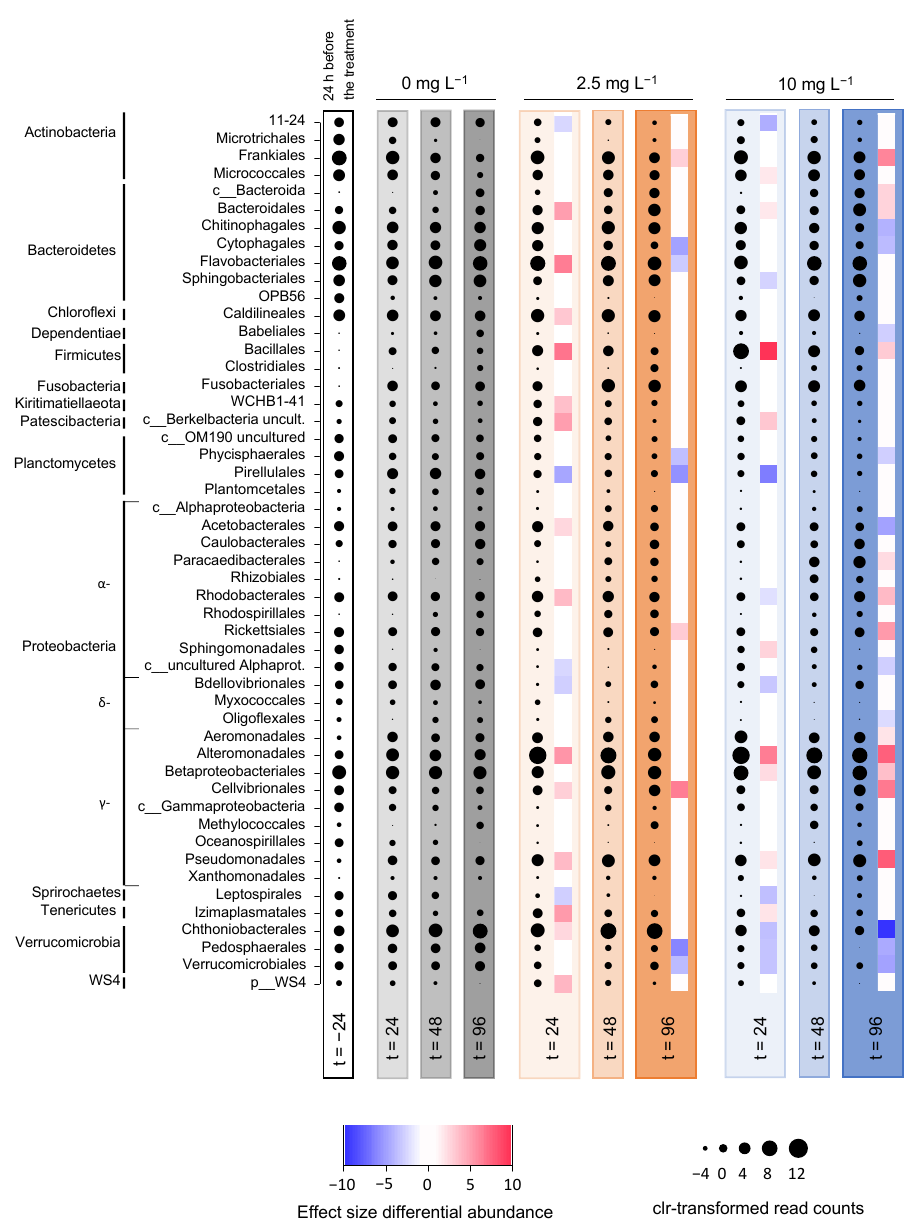
Figure 6. Microbial community composition during the incubation experiments in August. The graph shows the relative abundances as clr-transformed read counts of bacteria at the order level for each of the time points during the August treatment. The first column represents the average relative abundances in the lake prior to the incubation experiments (t = − 24 h, with n = seven biological replicates). The other columns represent the relative abundances in the incubation experiments at three subsequent time points (t = 24, 48 and 96 h, with n = four biological replicates per time point). Gray columns represent the control incubations (0 mg L − 1 H 2 O 2 ), orange columns—the 2.5 mg L − 1 H 2 O 2 -treated incubations, blue columns—the 10 mg L − 1 H 2 O 2 -treated incubations. Differential abundances of orders between the treated and control incubations at t = 24 h and t = 96 h were calculated using ALDEx2. Effect sizes of the statistical test (0.7 × Cohen’s d ) are shown in the heat map next to the t = 24 and t = 96 columns for all the significant comparisons; blue indicates a significant decrease in the relative abundance while red indicates a significant increase in the relative abundance in comparison to the control; “p__” and “c__” indicate that the maximum classification of these taxa is at the phylum and class level,